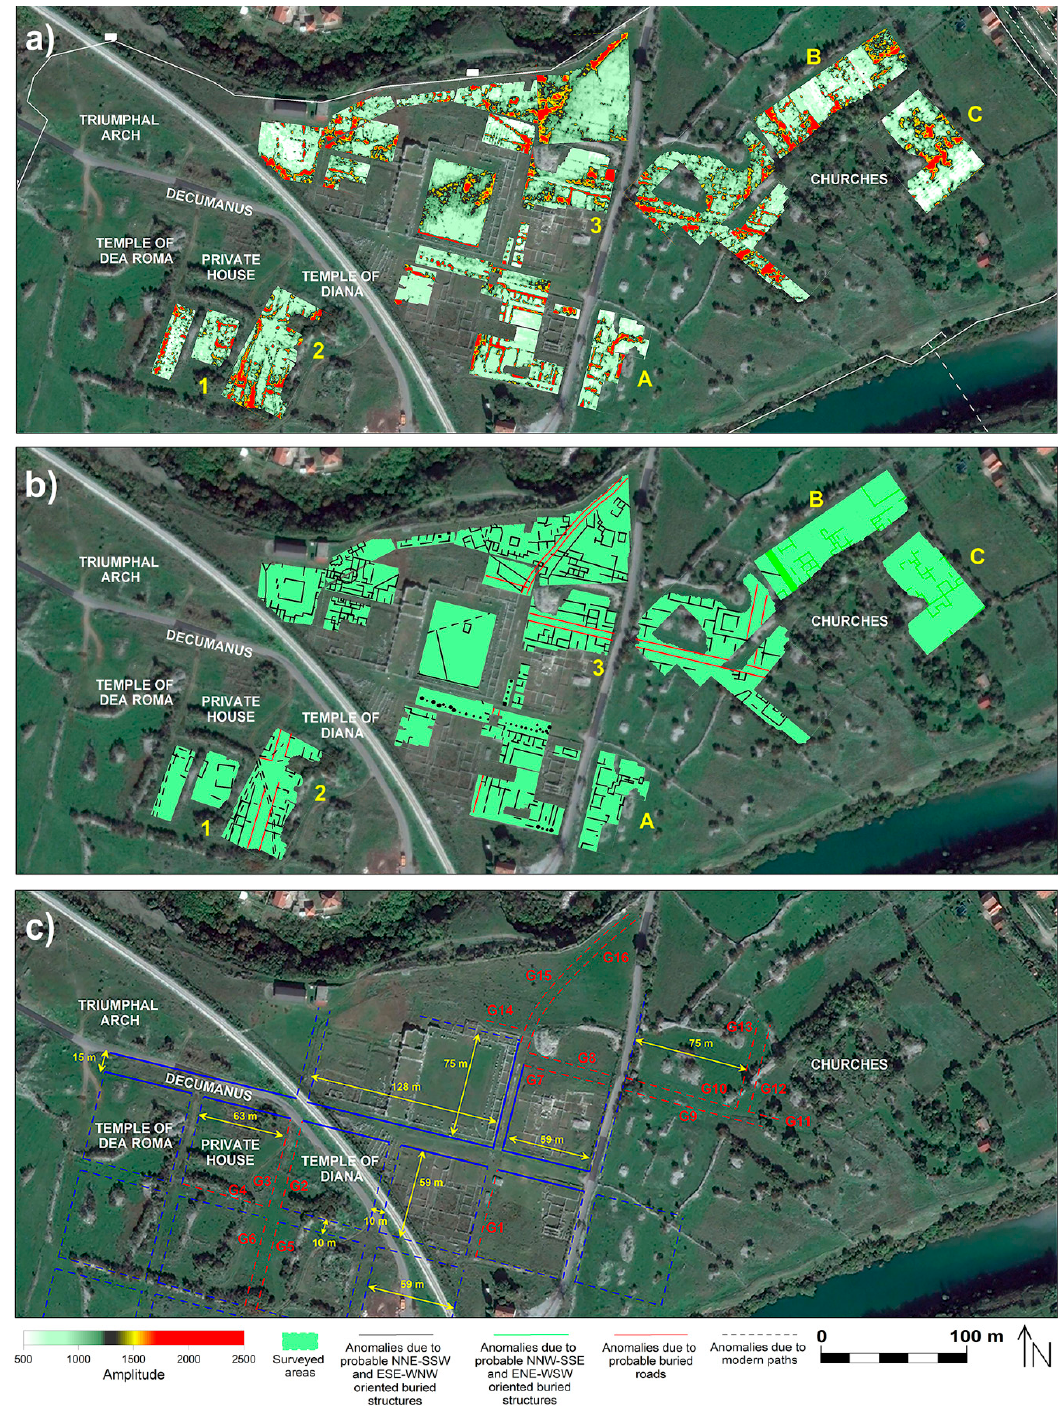
Figure 10. Doclea: GPR time slice relative to the time window 14–18 ns, overlapped on the satellite image of Google Earth TM ( a ), identification of anomalies ( b ) and hypothetical reconstruction of the urban settlement ( c ).